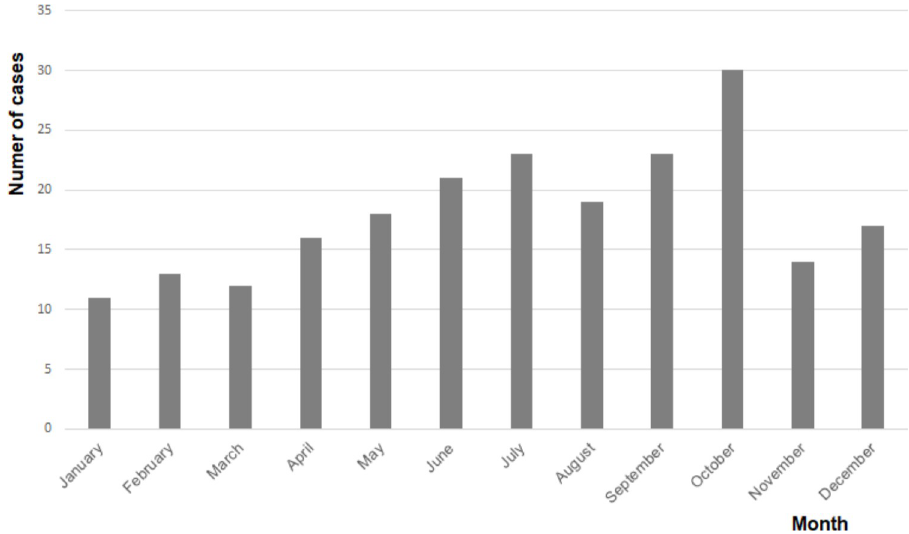
Fig 2. Number of cases per month. The cumulative number of cases of Acanthamoeba keratitis per month in the Netherlands, between 2009 and 2015.